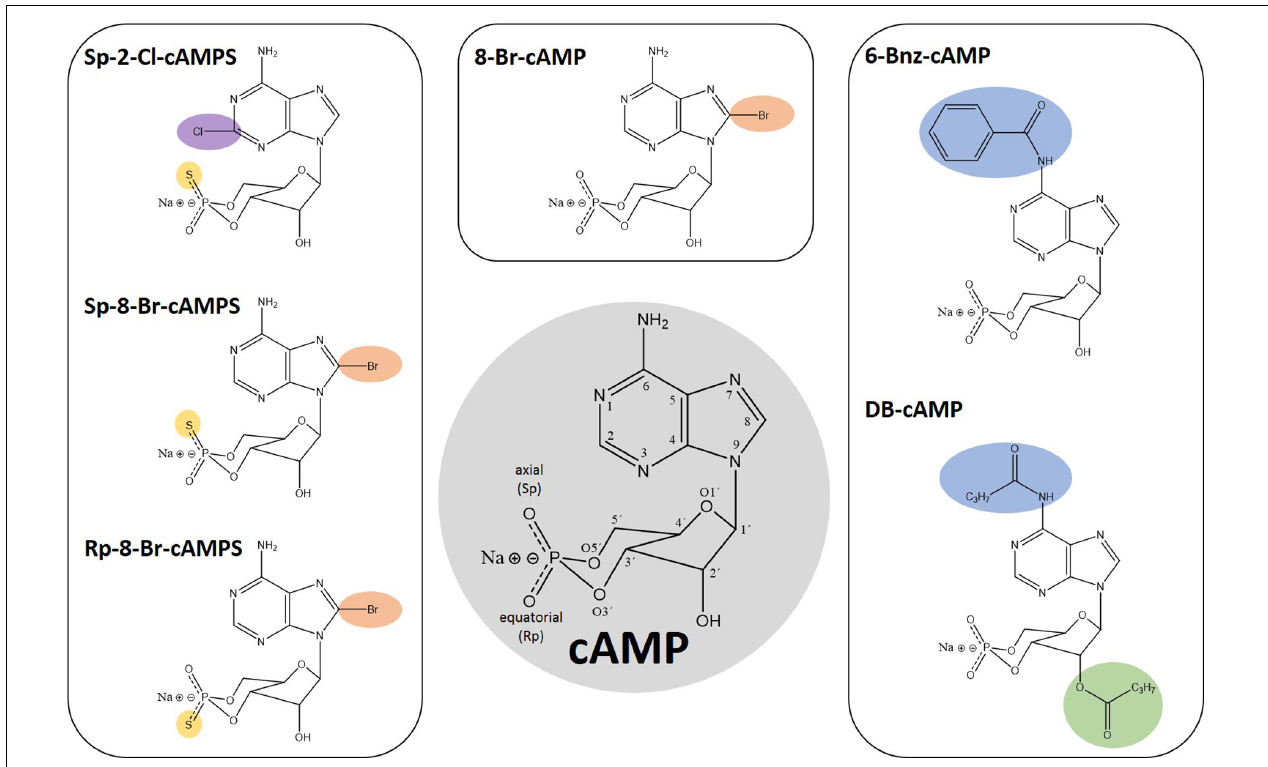
FIGURE 1 | Chemical structures of cAMP and analogs thereof. Numbers in the cAMP structure highlighted in gray indicate the position 1–9 in the adenine ring, 1 (cid:48) –6 (cid:48) in the sugar moiety as well as the oxygen positions of the cyclic phosphate moiety. The modifications of the depicted analogs are highlighted in color according to their positions: Pos. 2, 6, and 8 in the adenine ring in purple, blue, and orange, respectively. The 2’ position in the sugar moiety is depicted in green and the exchange of exocyclic oxygen to sulfur in the cyclic phosphate moiety is highlighted in